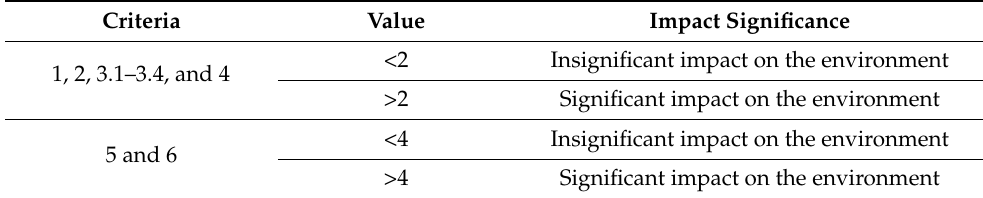
Table 2. Interpretation scale for environmental impact